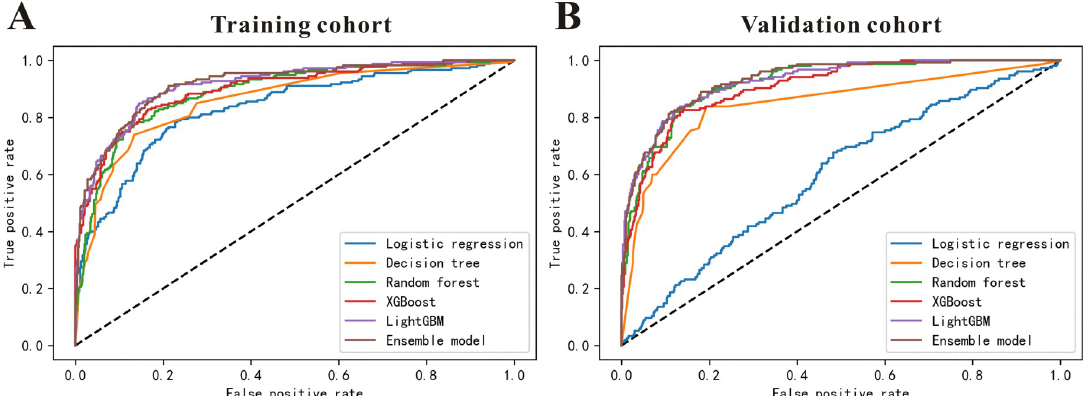
Fig 2. The performance of the six in-hospital mortality predictive models. ROC curves of the six prediction models using all features for predicting in-hospital mortality ( A ) in training cohort and ( B ) in the validation cohort.